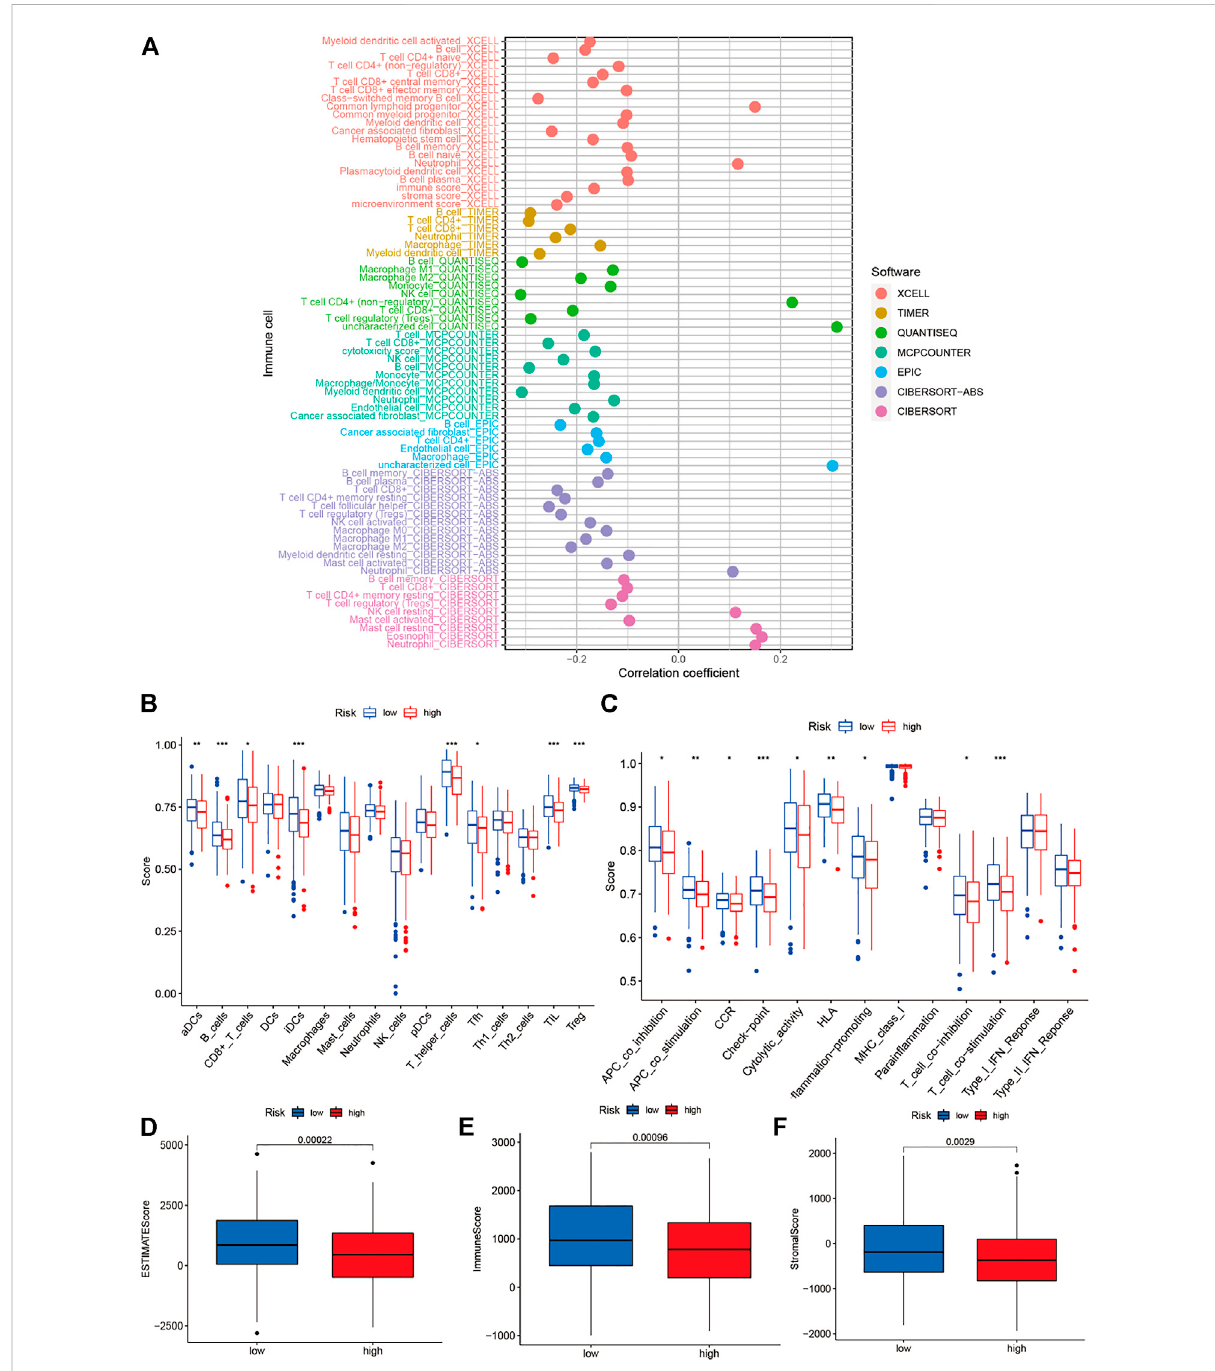
FIGURE 9 Analysis of tumor microenvironment and of degrees mmune cell in fi ltration. (A) Determination of the relationship between immune cells and risk scores using different calculation methods; (B – C) Immune cell and immune-related function scores were obtained using the single-sample gene set enrichment analysis technique; and (D – F) The differences between the immune cell in fi ltration levels in the low- and high-risk